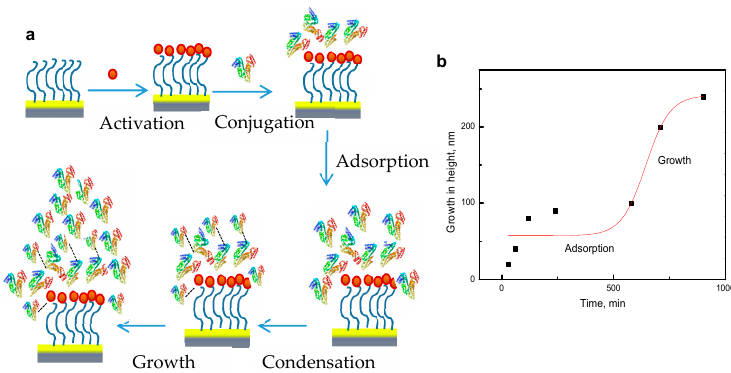
Figure 2. Mechanism of pattern formation: ( a ) scheme of protein self-assembly and ( b ) growth in height of the self-assembly with time.